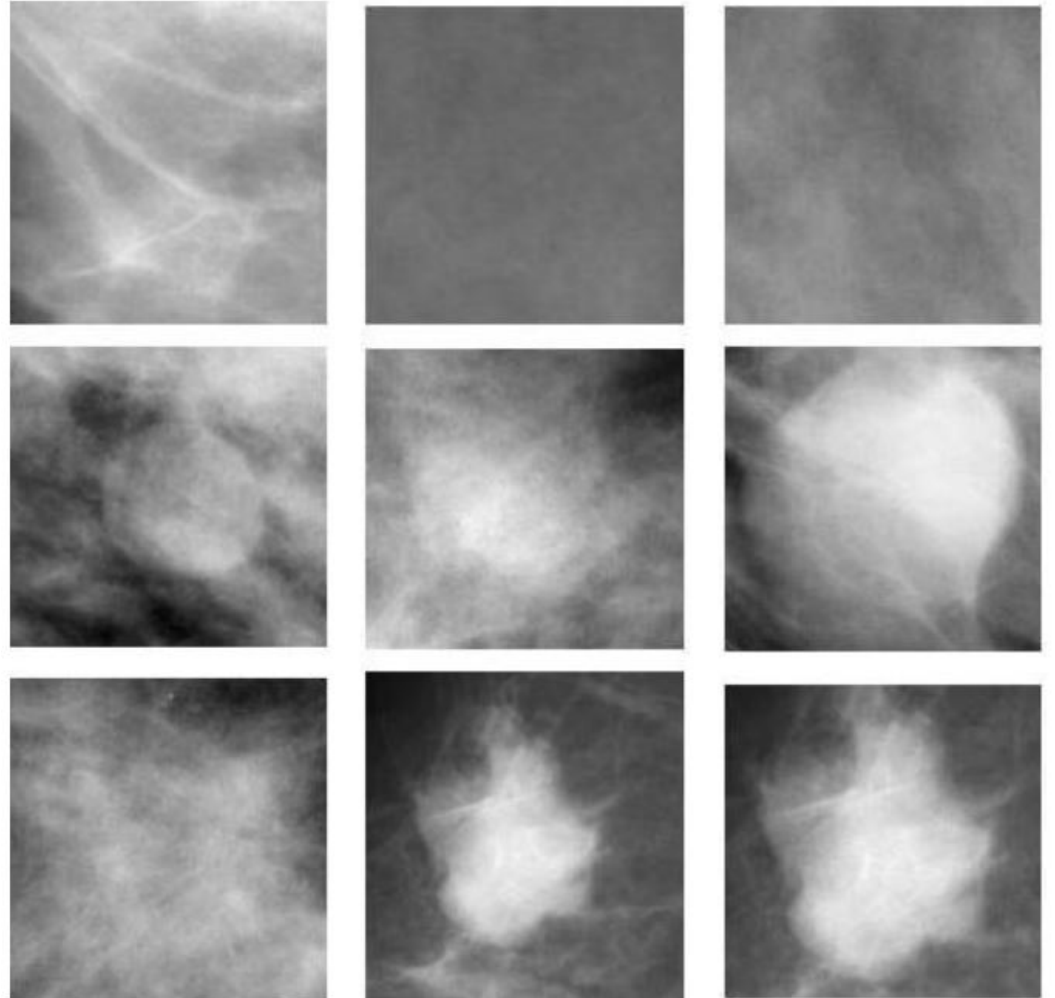
Figure 4. Samples regions of the DDSM dataset; first row is regions with normal breast parenchyma, second row is a set benign ROI, and malignant masses are shown in the third